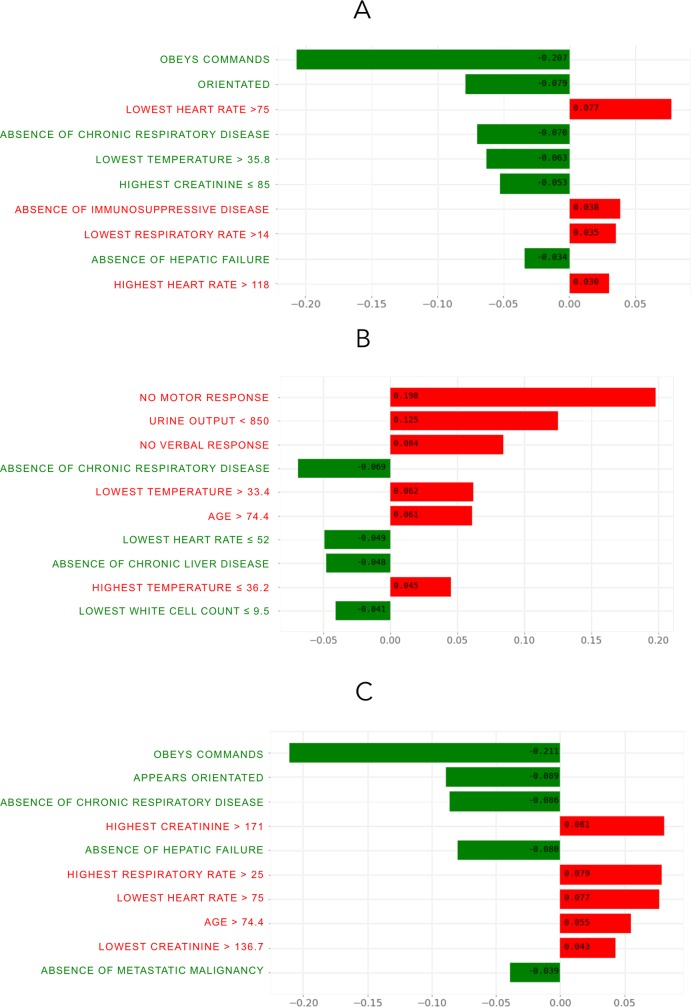
Local interpretable model explainer for 3 individual cases.(A) A correctly classified survivor, (B) a correctly classified non-survivor, and (C) an incorrectly classified non-survivor (predicted to survive). Features with a green bar favoured survival, and those with a red bar were predictive of mortality. The x-axis shows how much each feature added or subtracted to the final probability value for the patient (i.e., a feature with a weight of 0.2 is equivalent to a 20% change in the probability of survival).